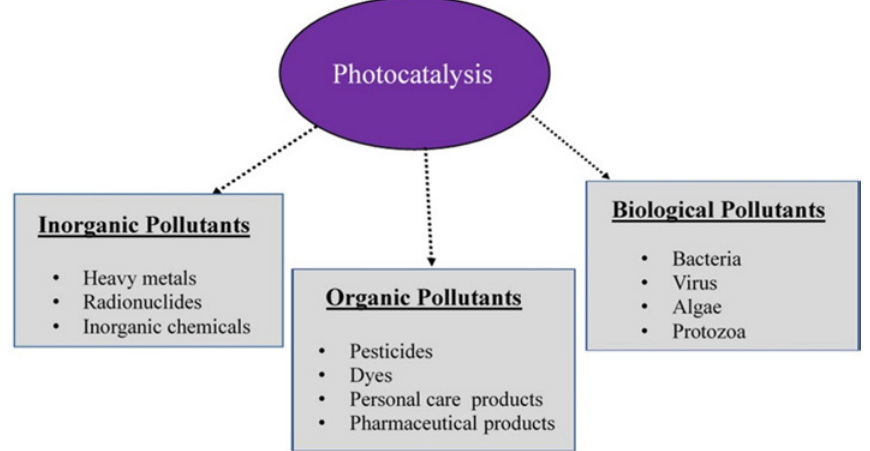
Fig. 1. Application of Photocatalysis for the removal of different types of water